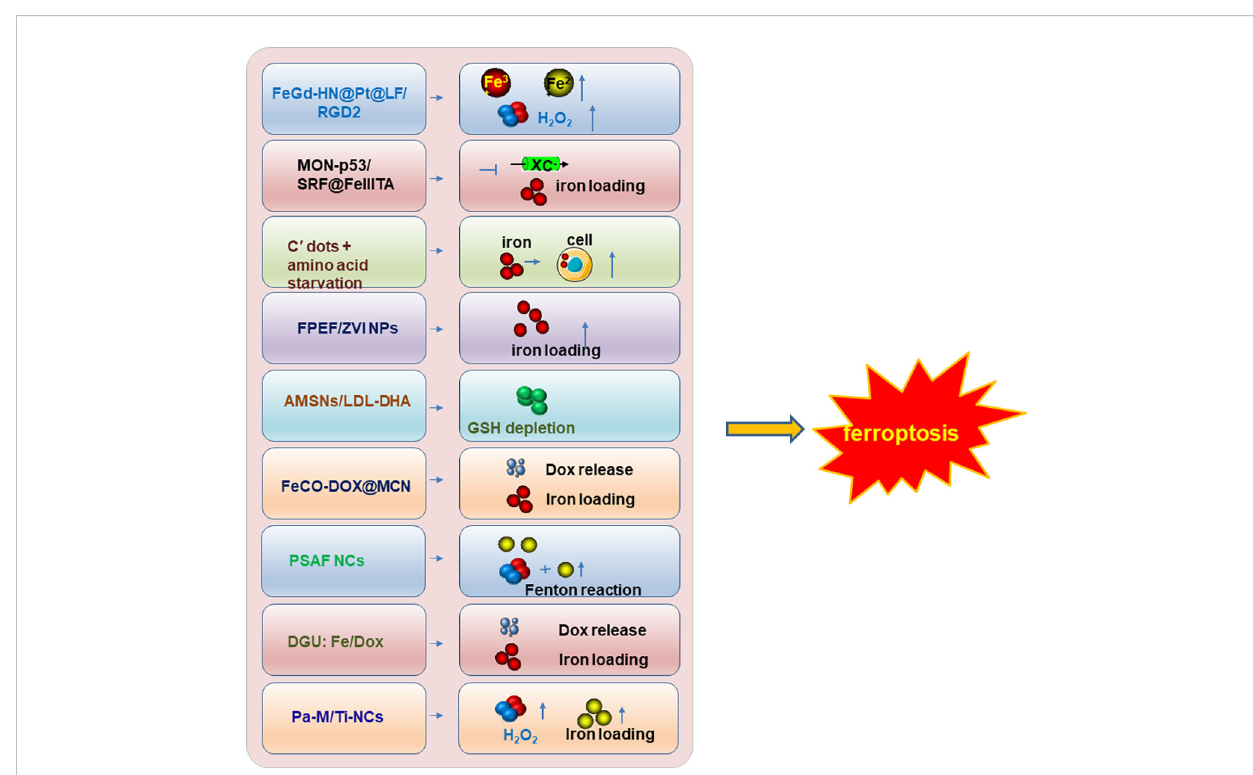
FIGURE 5 The nanoparticle inducers to trigger ferroptosis. The developed nanoparticle inducers to trigger ferroptosis and their functional mechanisms were illustrated in the fi gure. And these ferroptosis inducers are designed based on the nanoparticles. Not all the currently reported nanoparticle inducers were listed in the fi gure and only one of the ferroptosis inducers was illustrated in the fi gure as a representative of each kind of inducers. Modi fi ed according to